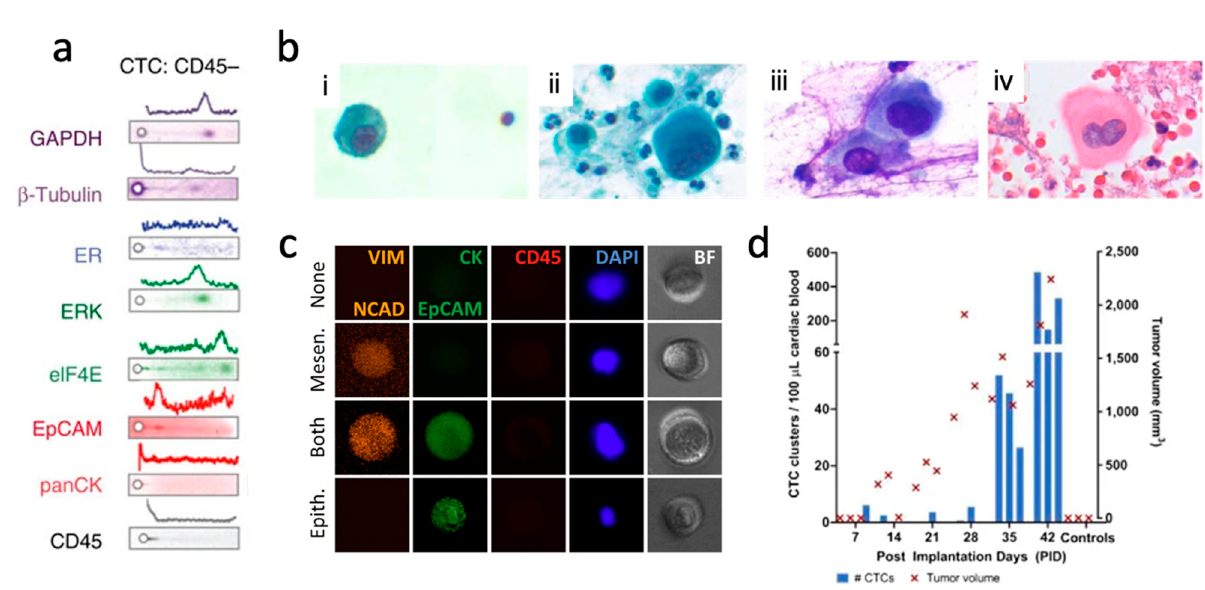
Figure 4. Label-free CTC isolation is necessary for unbiased CTCs studies. ( a ) Patient-derived single-CTC lysate is analyzed by single-cell Western blotting and rounds of immunoprobing against a wide array of signaling and onco-proteins relevant to cancer. Reprinted from [61]; permission conveyed through CC BY 4.0. ( b ) The cytological analysis revealed that CTC (i) revealed binucleation, which was also seen in a Pap stain (ii) and MGG stain (iii) of the patient’s pleural fluid and H&E stain (iv) of a primary tumor sample. Adapted from [50]; permission conveyed through CC BY 4.0. ( c ) Immunofluorescence staining of mesenchymal (VIM, NCAD) and epithelial (CK, EpCAM) markers revealed cellular heterogeneity. CTCs (CD45-) may or may not express these markers, depending on their EMT status. Reprinted from [68]; permission conveyed through CC BY 3.0. ( d ) Relationship between tumor volume with elevated CTC clusters counts per 100 µL of cardiac blood in a xenograft mouse model. Reprinted from [69]; permission conveyed through CC BY 4.0.